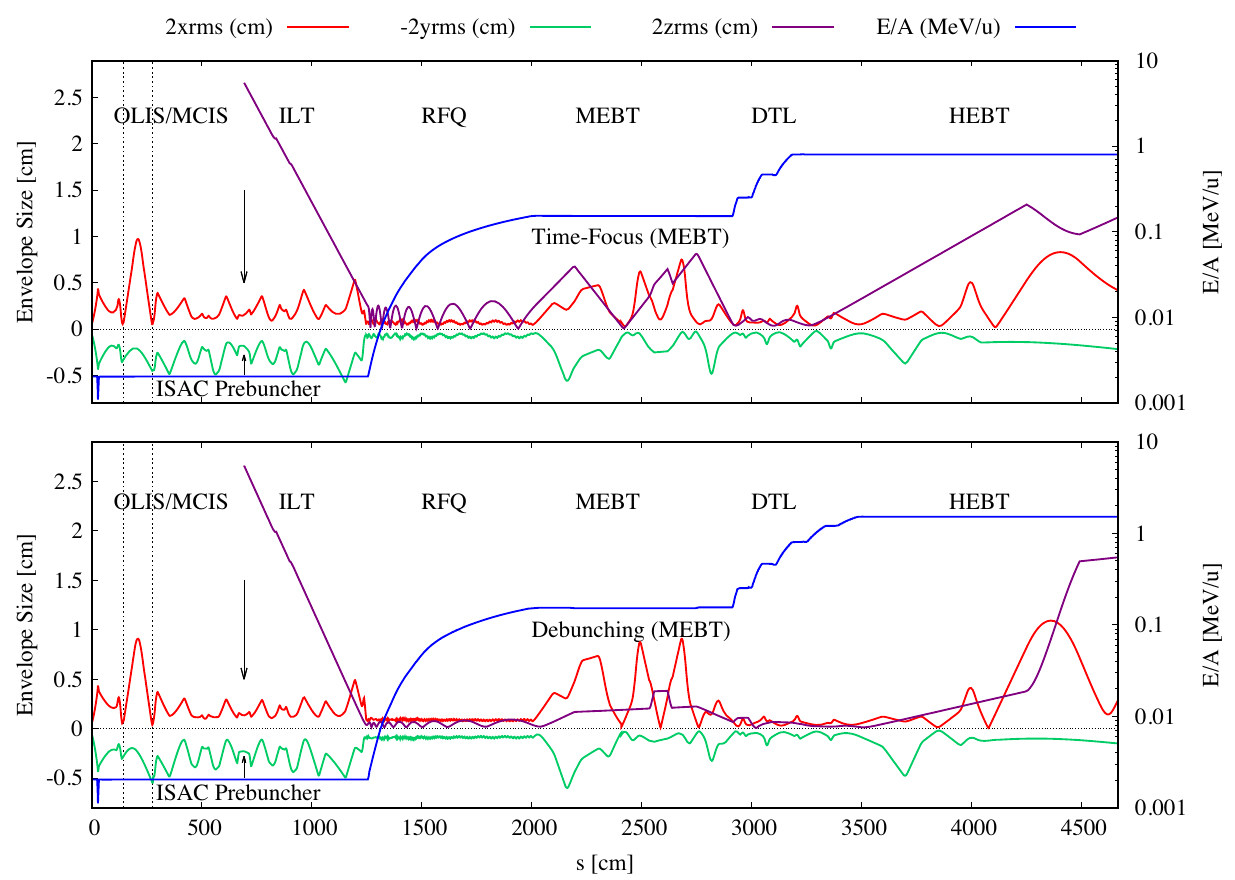
FIG. 11. TRANSOPTR computations of 2 rms envelopes and reference particle energy for a 20 Ne 4 þ beam in the ISAC-I linac, from OLIS extraction at E=A ¼ 2 . 04 keV = u up to the Prague Magnet station (Fig. 1). The dip in E=A near s ¼ 0 is from a decelerating Einzel lens [53]. The OLIS slits are shown as vertical dashed lines. The code is run in 6D bunched mode, with initial longitudinal beam matrix values chosen to mimic the acceptance of the prebuncher, which is represented as a single discrete 11 MHz rf kick (arrows), though OLIS beams are continuous. The starting energy spread is equal to the prebuncher ’ s three harmonic waveform deviation from a perfect sawtooth. The top shows the ISAC-DTL configured for acceleration up to 0.803 MeV/u. The DTL triplets and HEBT optics have been reoptimized, along with Tanks 4 and 5, to retune the linac to 1.53 MeV/u acceleration in the bottom figure. The longitudinal mismatch into the RFQ is corrected by optimizing the prebuncher and low-energy optics. Additionally, the MEBT time focus (top) has been retuned to debunch the beam longitudinally (bottom), requiring a change in MEBT & DTL rf settings. The high-energy analyzing magnet (Fig. 1) is located between s ¼ 4200 and 4600 cm, upstream of the parallel wire